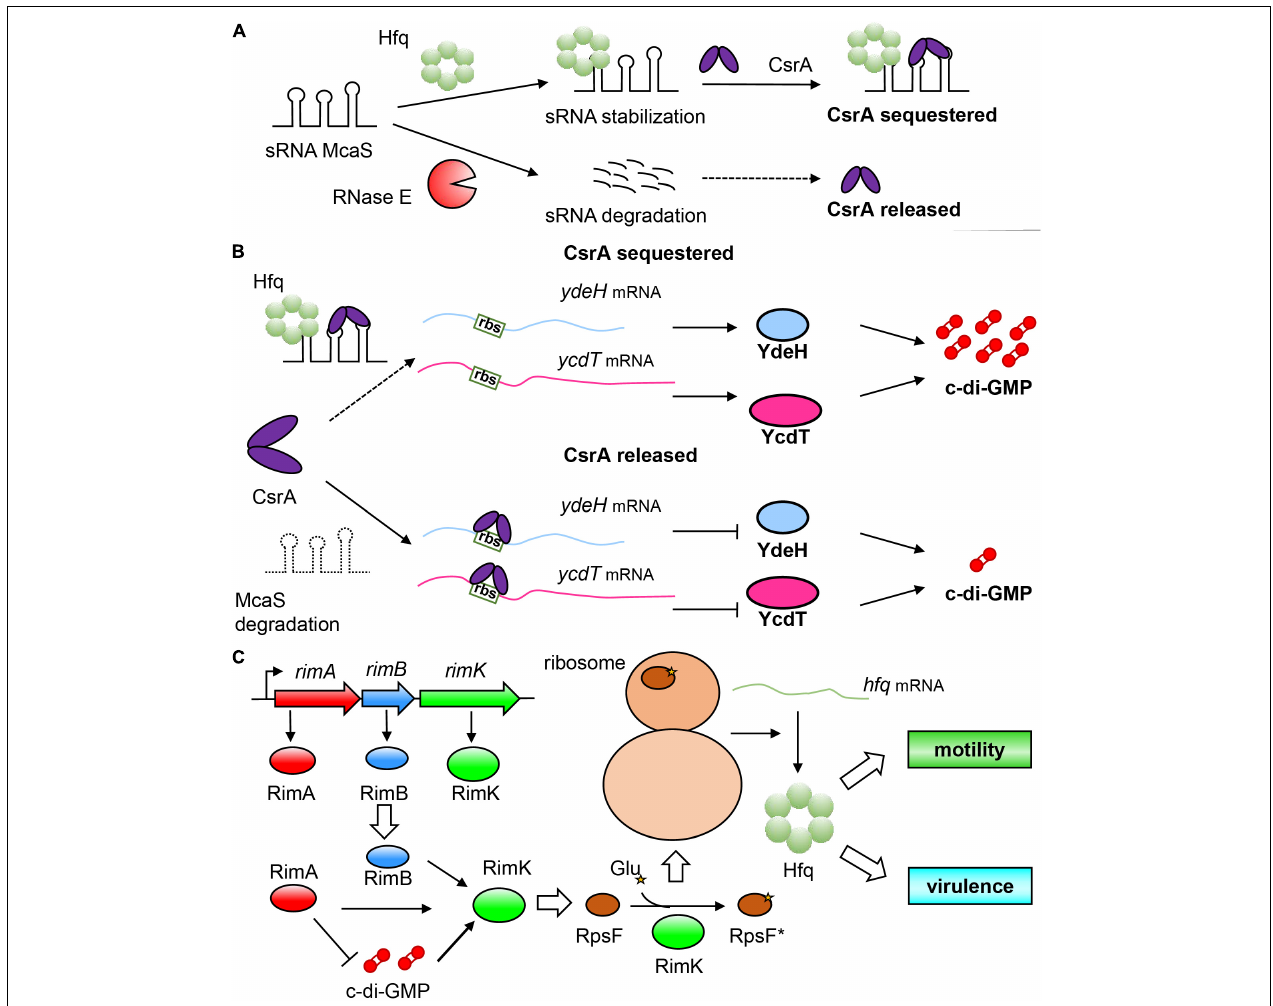
FIGURE 4 | Indirect and mutual regulation between Hfq and c-di-GMP systems. (A) A complicated regulatory relationship between sRNA McaS and RNA binding proteins Hfq and CsrA. sRNA McaS can bind to two RNA binding proteins CsrA and Hfq through different binding motifs. When Hfq is present, McaS is stabilized to adopt a conformation non-degradable by RNase E. The stable McaS then binds with CsrA, disabling its regulation on target mRNA; on the contrary, when Hfq is not present, McaS will be degraded, allowing free CsrA to play a regulatory role on target mRNA. (B) Hfq regulates the concentration of c-di-GMP by affecting the stability of sRNA McaS, thereby causing McaS to capture CsrA. In the presence of Hfq, McaS adopts a stable conformation, and binds strongly with CsrA to prevent it from blocking the ribosome binding sites of ydeH and ycdT mRNA, so that they can be translated normally (The above is reasonable speculation); while without Hfq, McaS cannot adopt a stable conformation to capture CsrA, which is then released to bind to the ribosome binding site of ydeH and ycdT mRNA, resulting in translation inhibition. (C) c-di-GMP and RimA, RimB, RimK, and RpsF co-regulate regulate Hfq. RimA (a PDE), RimB and RimK are encoded by the operon rimABK. Importantly, RimK is a glutamate ligase, which can transfer glutamate residues to the C-terminus of RpsF (Protein S6), so that RpsF is activated to become RpsF* (asterisks indicate the glutamate residues), which can interact with ribosomal proteins to regulate downstream gene activity and fine-tune the entire proteome of bacteria, thereby affecting the expression of Hfq